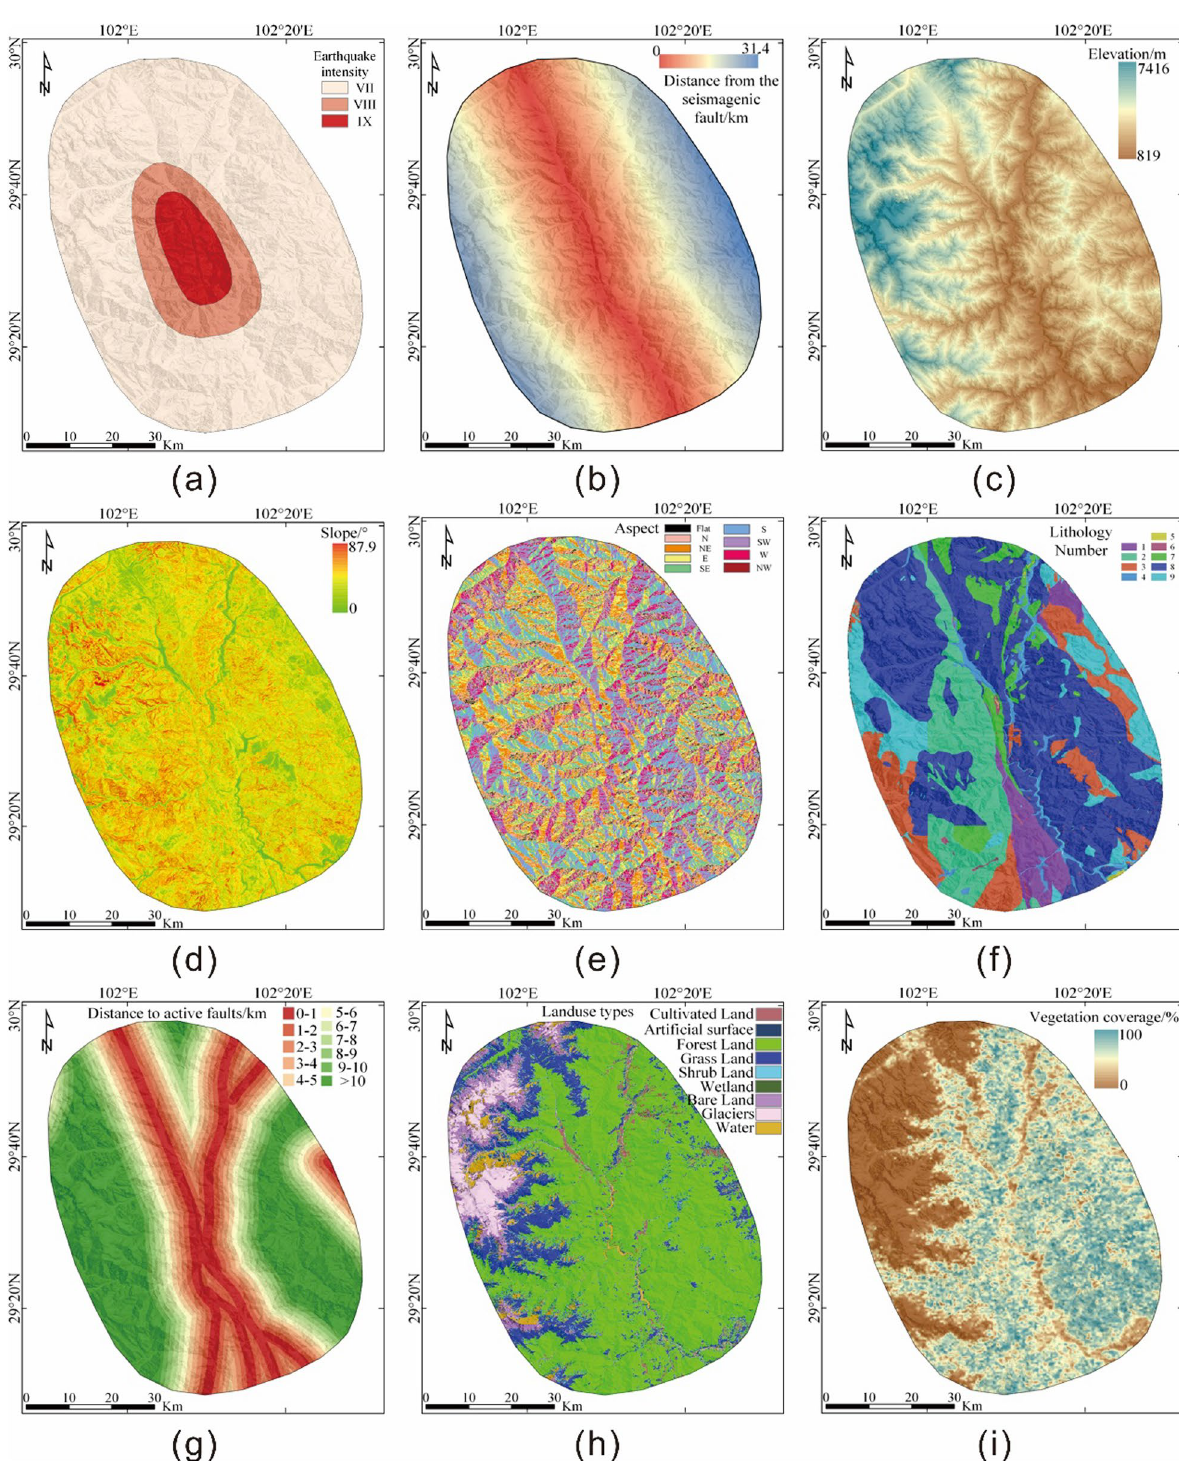
Fig. 3 Maps showing the distribution of the influencing factors in the study area. a Earthquake intensity. b Distance to seismogenic fault. c Altitude. d Slope. e Aspect of slope f Lithology. g Distance to active fault. h Land use type. i Vegetation